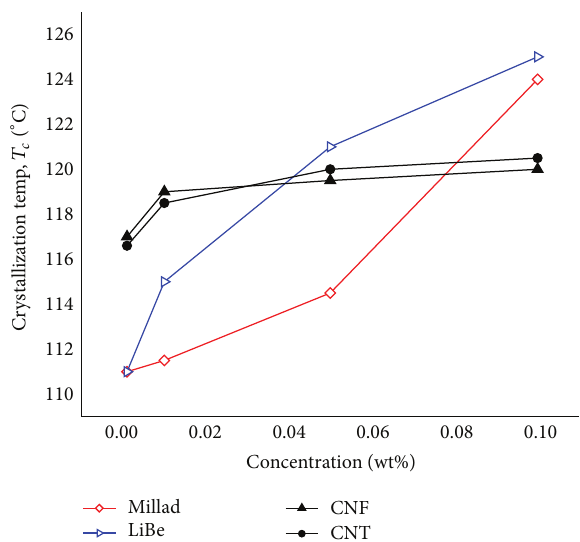
Figure 2: Variation of the crystallization temperature ( 𝑇 𝑐 ) of iPP with the nucleating agents concentration (0.001, 0.01, 0.05, and 0.10 wt%).